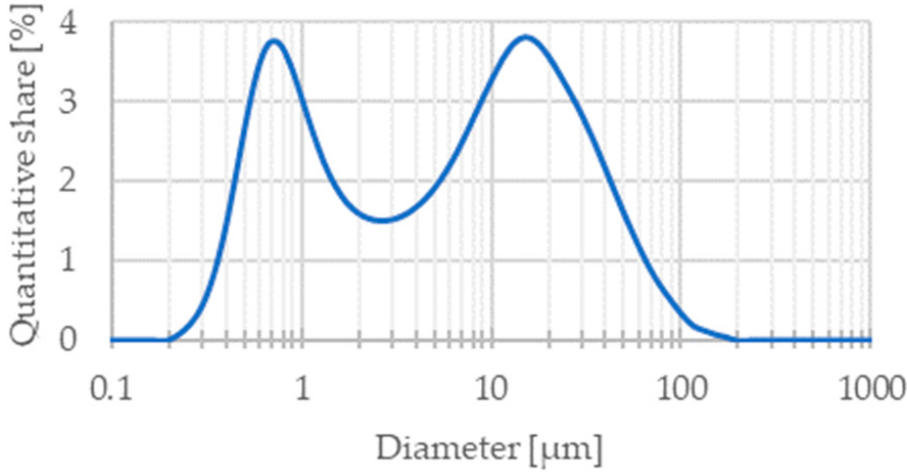
Figure 3. Particle size distribution of SDC powder by laser-scattering method.